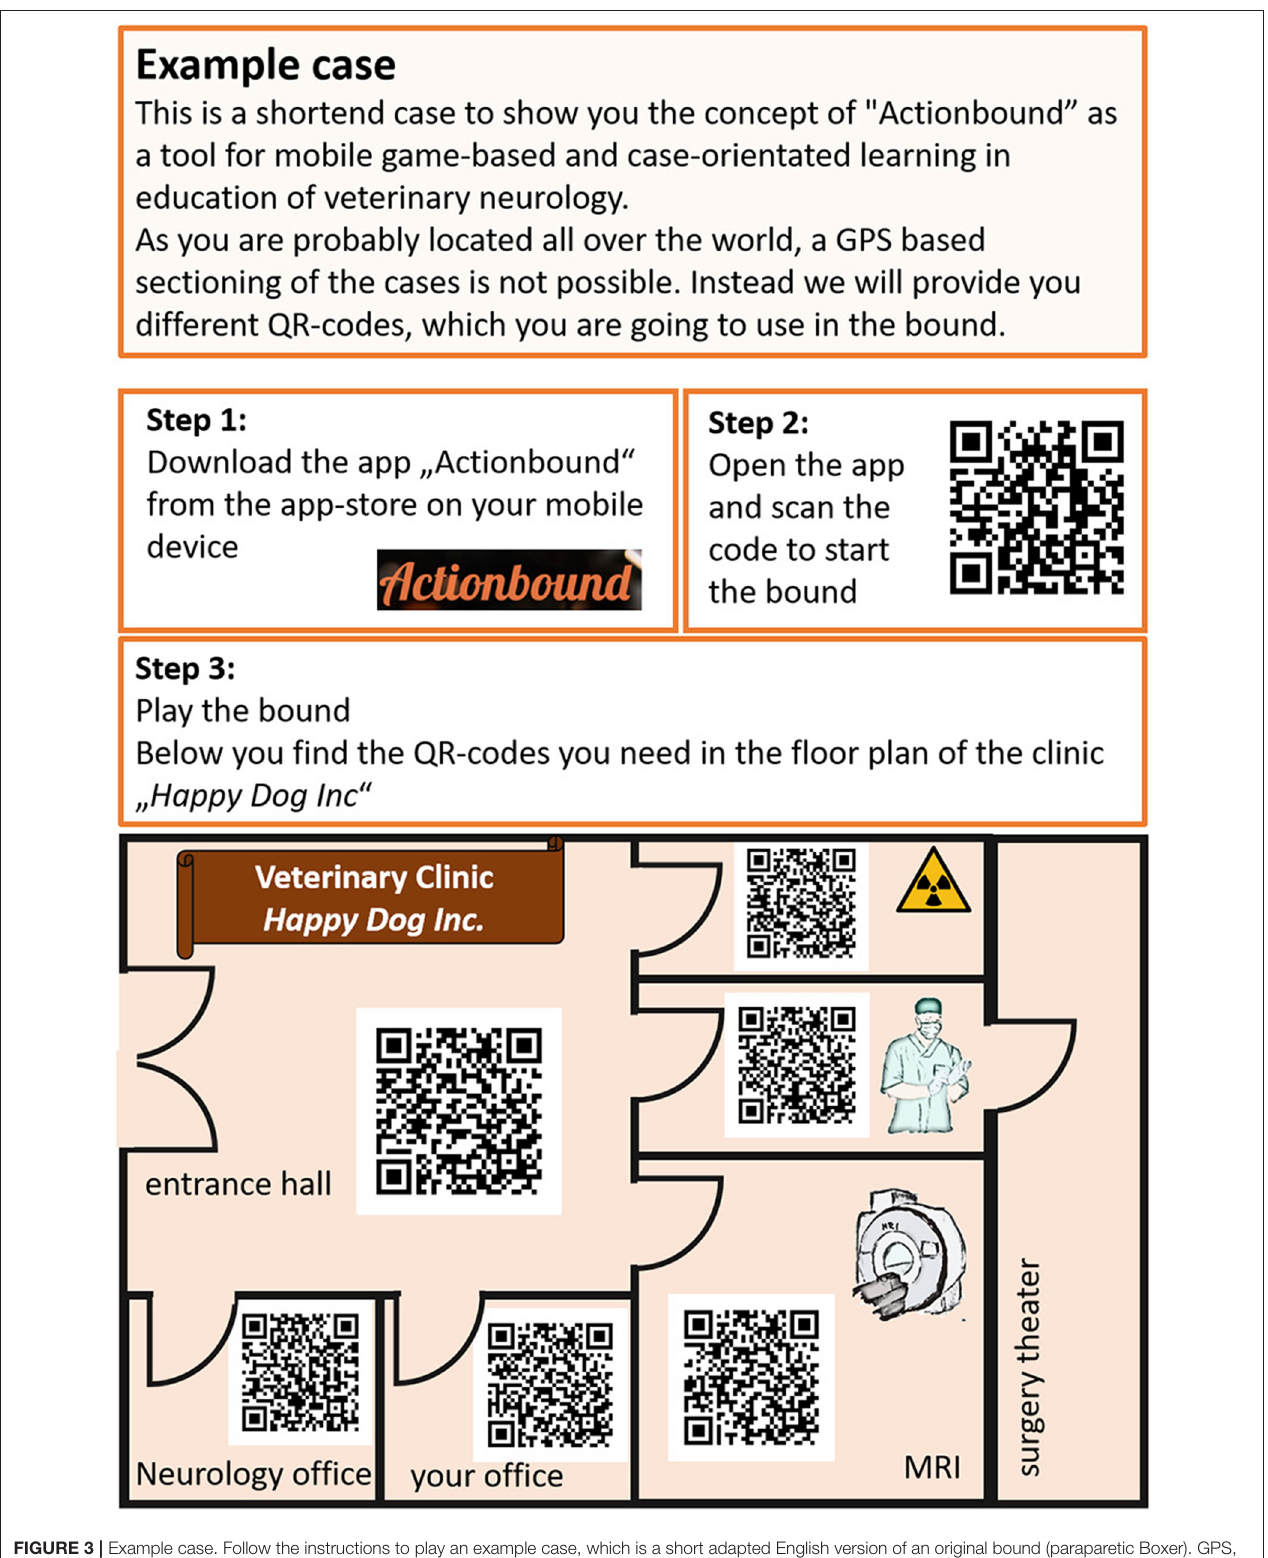
Frontiers in Veterinary Science |